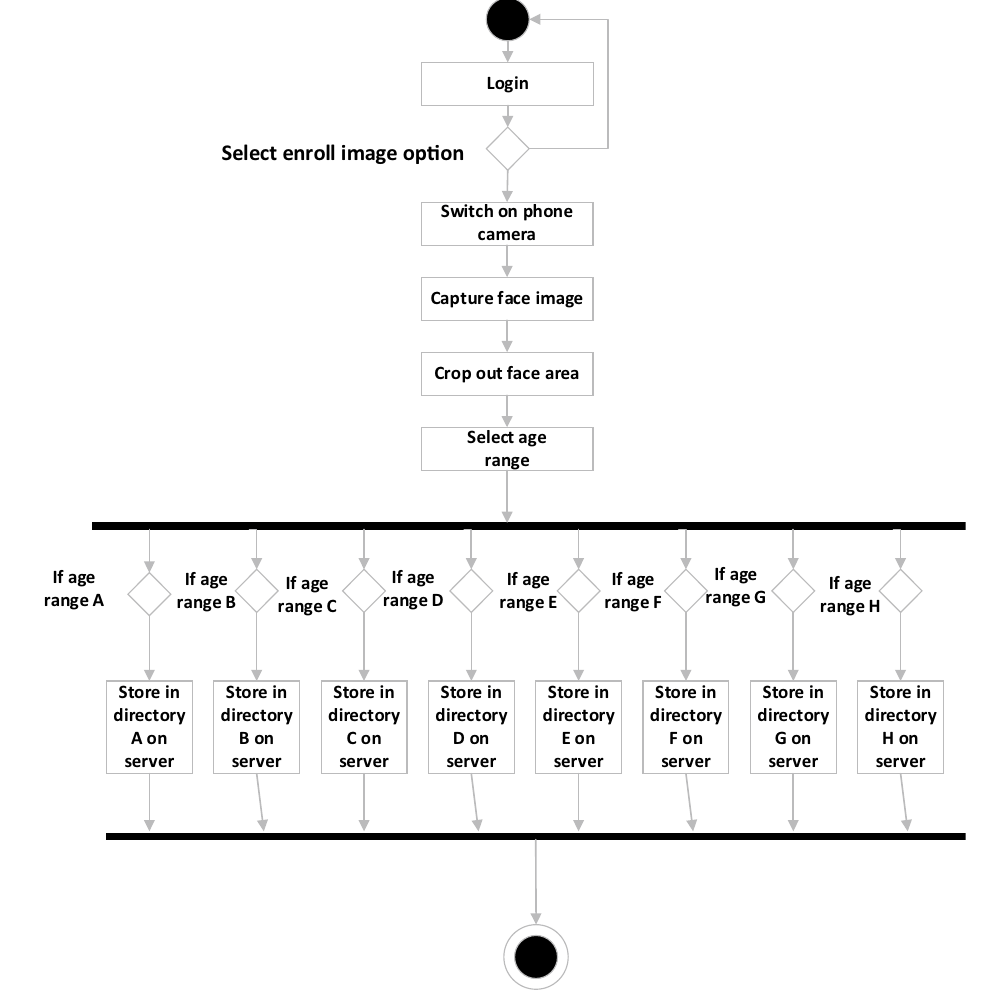
Figure 7. Activity diagram for the image acquisition